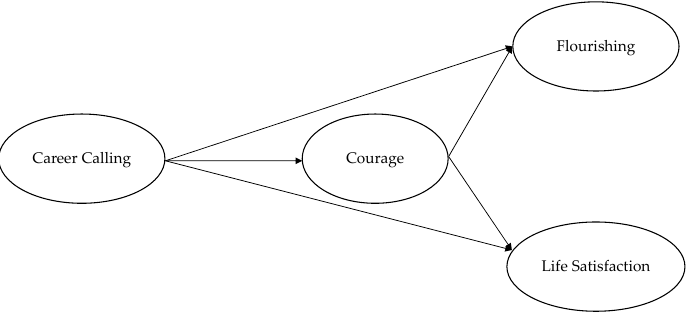
Figure 1. Hypothesized model.